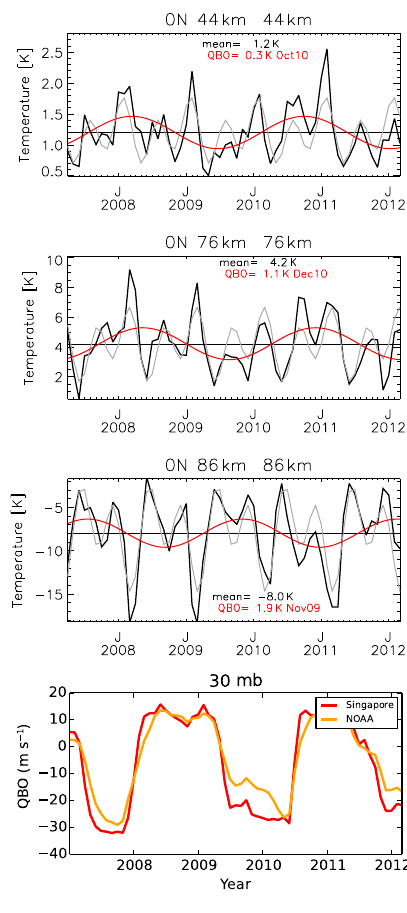
Figure 14. MIPAS monthly mean | n odd − s | = 0 mode perturbations (black lines) at 44, 76 and 86km and their decomposition in an- nual plus semiannual components (grey) and QBO (red). Singapore winds at 30mb are also plotted in the bottom panel for